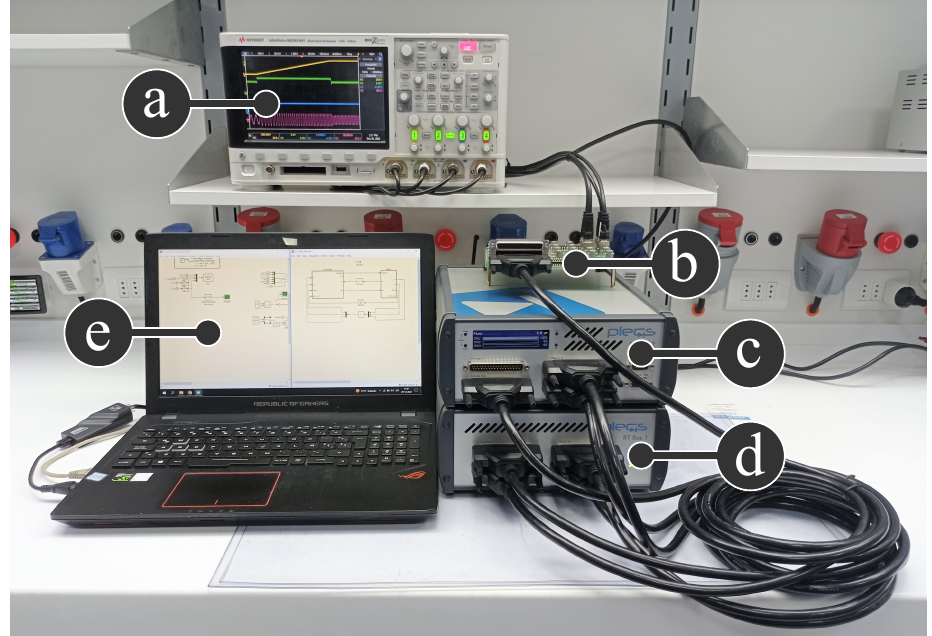
Figure 9. Experimental setup: ( a ) oscilloscope; ( b ) analog input board; ( c ) RT Box 1’ ( d ) RT Box 2; ( e )